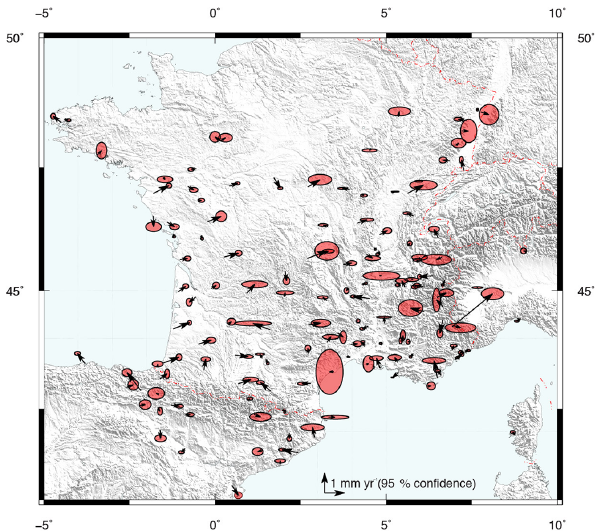
Figure 6. Horizontal velocities for stations with time series longer than 5 years in a regional (western Europe) reference frame.